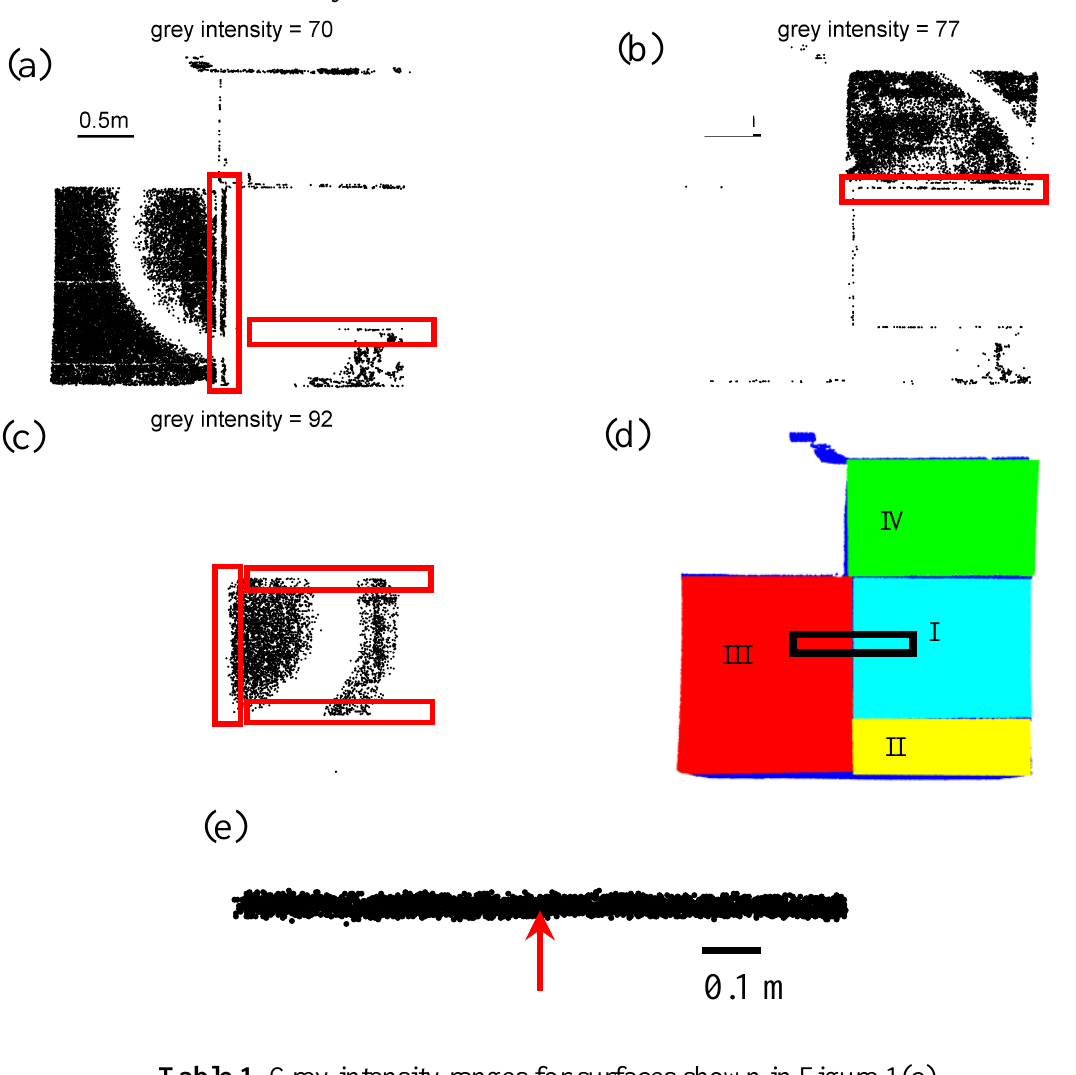
Figure 5. Results of four different surfaces [Figure 1(c)]: (a) grey intensity image of 70 showing surfaces III and II, (b) grey intensity image of 77 showing surface IV, (c) grey intensity image of 92 showing surface III, (d) Segmentation results using the visual cues of the concentric circular patterns and linear features dividing each concentric circular pattern [red rectangles in (a)-(c); see the text in Section 3.3 for explanation] shown in the intensity image sequence in Supplementary Material 3. Cyan, yellow, red, and green denote surfaces I, II, III, and IV, respectively, while blue represents un-segmented 3D laser points. (e) The nadir view of the subset of point cloud excerpted from the black rectangle in (d). The red arrow indicates the boundary between surface I and III in (d).